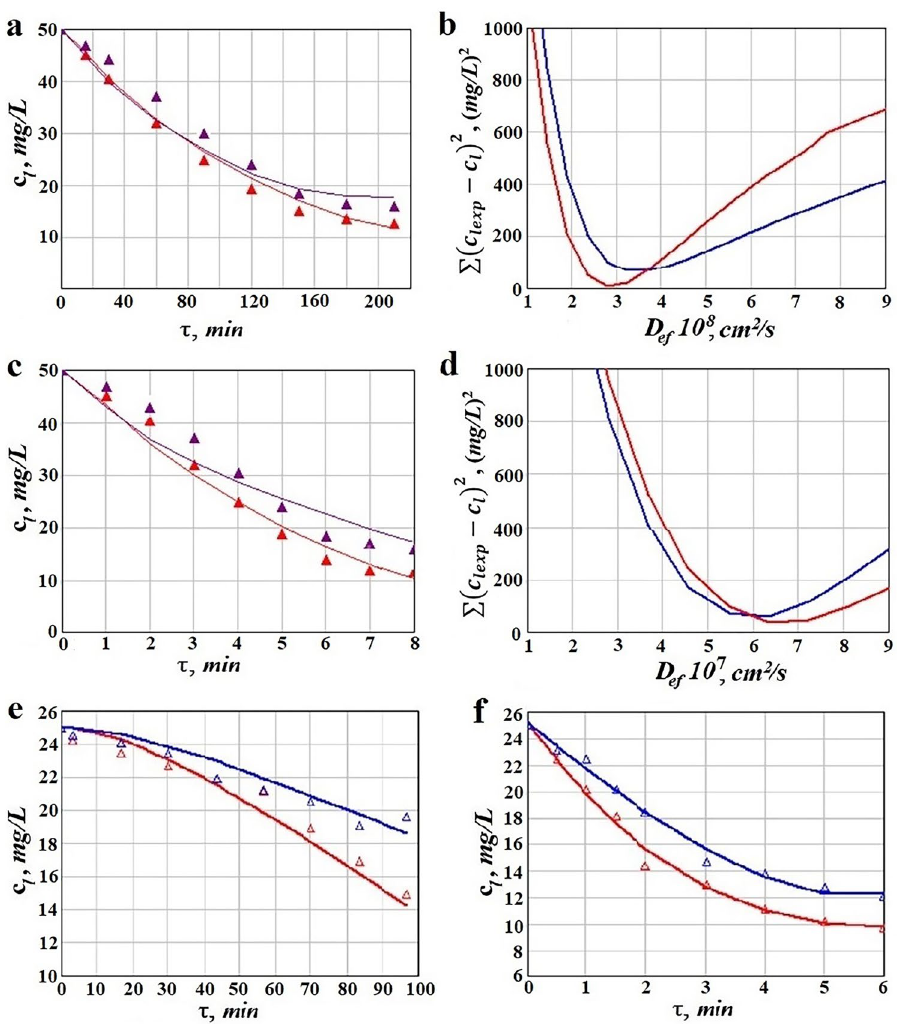
Figure 4. Dynamics of Pb(II) and Cd(II) concentration in liquid phase in time for: ( a ) single silent adsorption, ( b ) single US-assisted adsorption, ( e ) competitive silent adsorption, ( f ) competitive US-assisted adsorption, and sensitivity of mean square deviation of concentrations with respect to the diffusion coefficient for: ( b ) single silent adsorption, and ( d ) single US-assisted adsorption; continuous lines represents model data based on parameters given in Table 3, points represent experimental data; red colour is for Pb(II), blue for